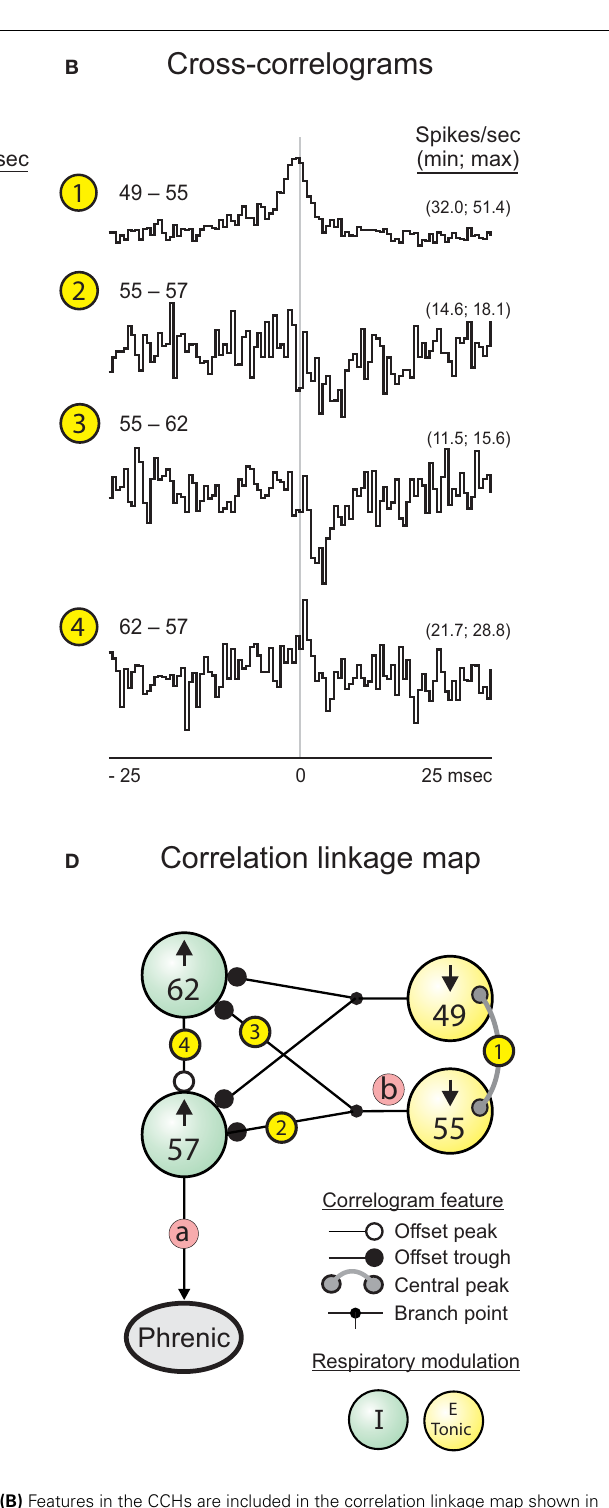
FIGURE 7 | Correlations among pairs ofVRC I and E neurons responsive to cough-eliciting tracheal stimulation. (A) Firing rate histograms (binwidths = 375.0ms) for 6 of 16 simultaneously recorded neuron spike trains during a double-cough response to tracheal stimulation. For each trace, the respiratory-modulated pattern, cell identification number, and maximum firing rate are shown. *, Amplitude of integrated phrenic (lumbar) nerve activity is ≥ 2SD above the mean maximum amplitude during eupneic period.